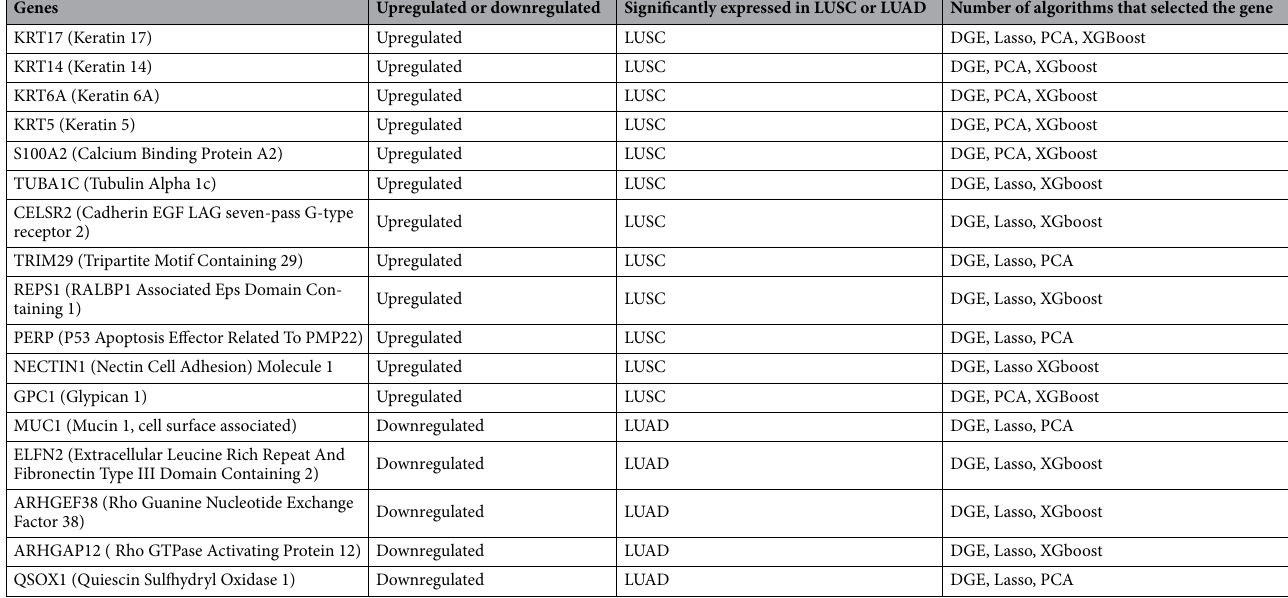
Table 2. 17 Biomarker candidate genes that were selected by three or